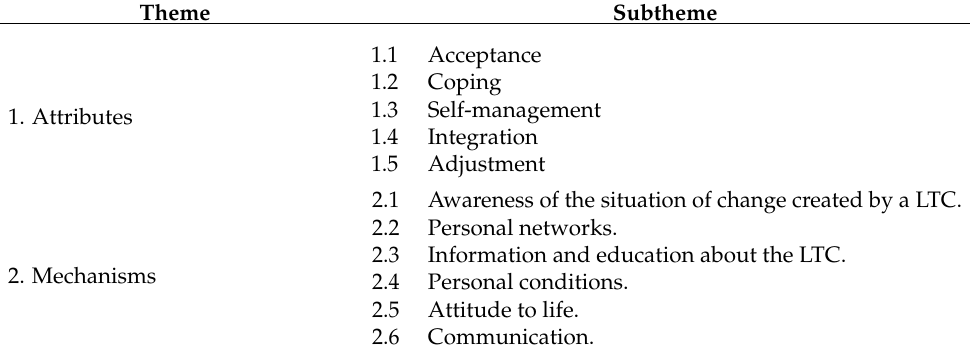
Table 3. Themes and subthemes